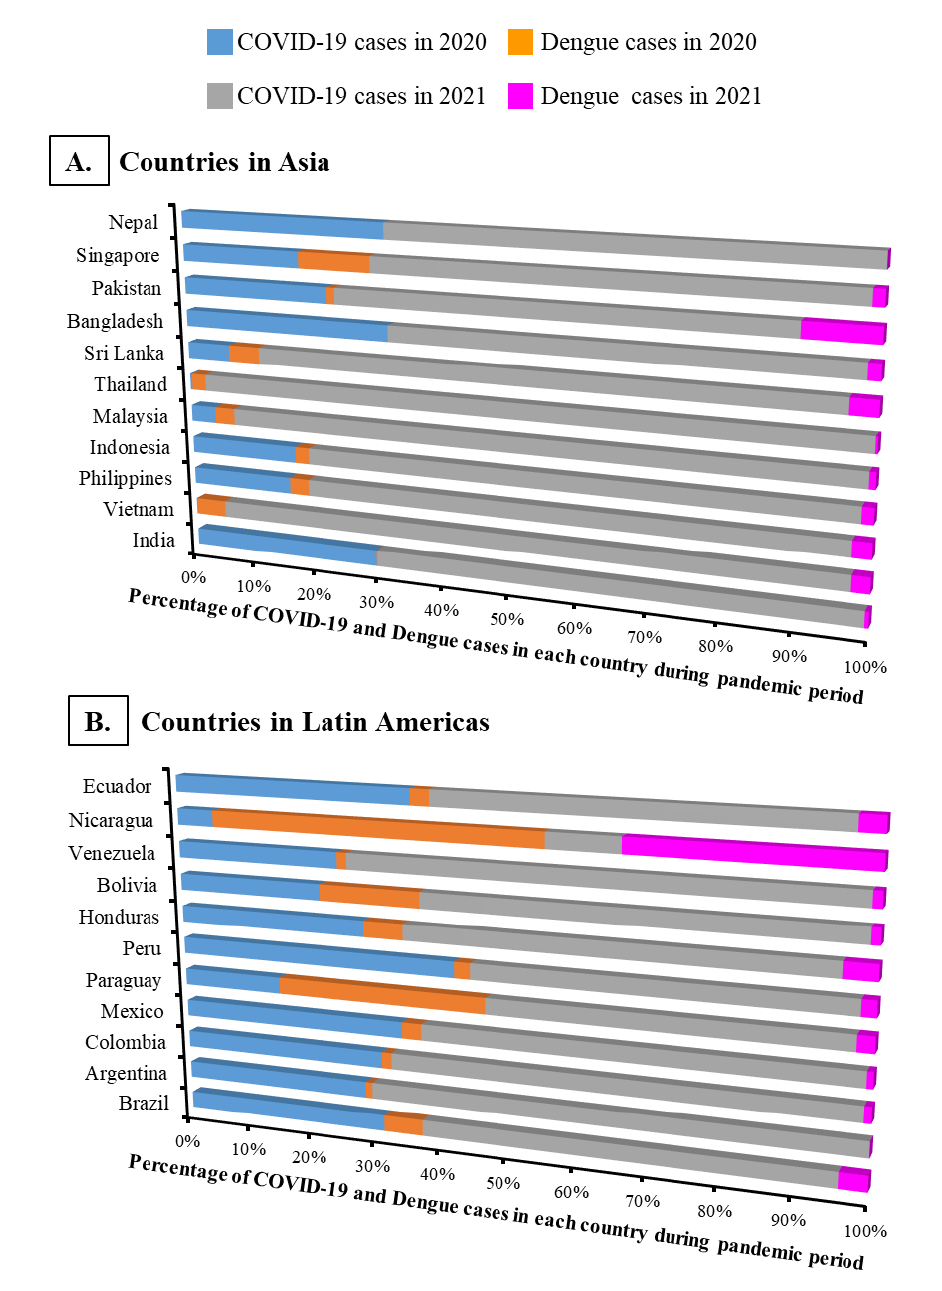
Figure 4. Country-wise percentage of dengue and COVID-19 incidences during the pandemic period (2020~2021). ( A ) Percentage of dengue and COVID-19 incidences in each country located in Asia. ( B ) Percentage of dengue and COVID-19 incidences in each country located in Latin